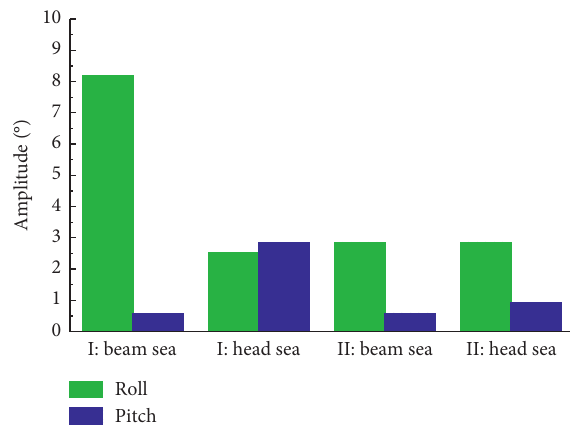
Figure 16: Comparative analysis diagram of ship motion ampli- tude under various working conditions.